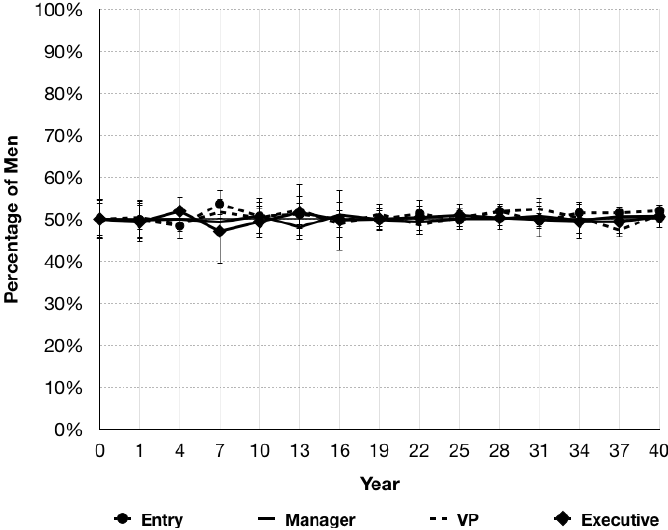
Figure 2. Fluctuations in gender balance across all four levels during a 40-year simulation. For this figure, the promotion and hiring biases are set to zero.